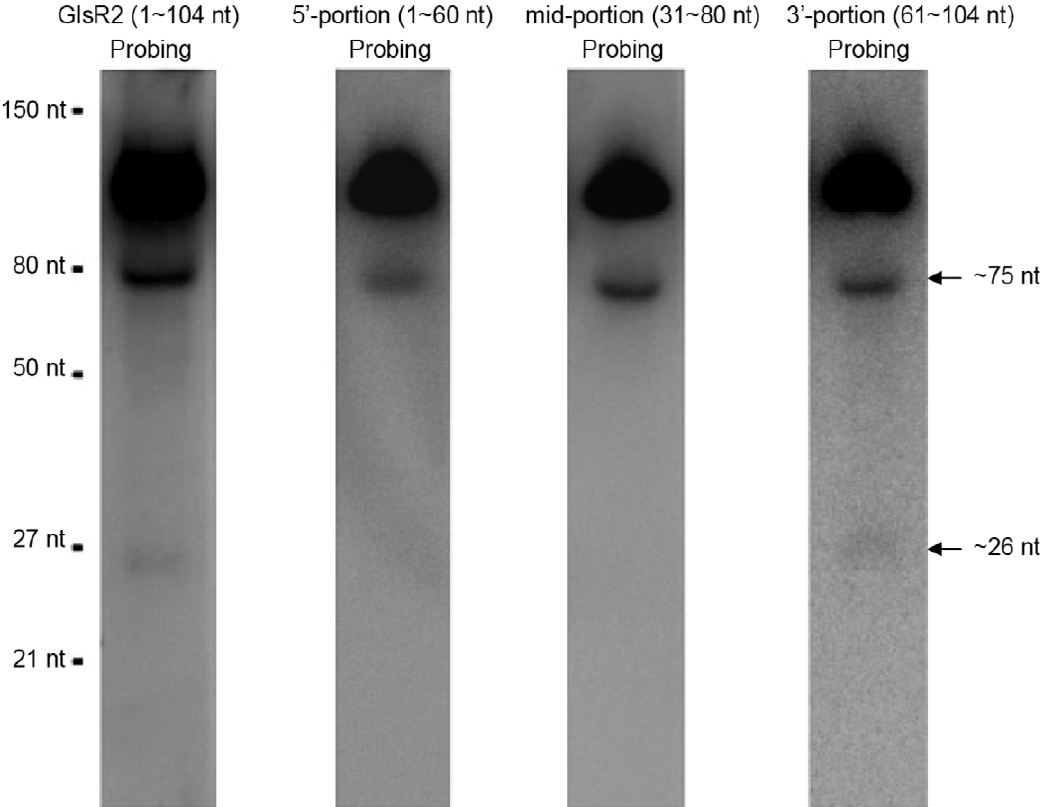
Figure 1. GlsR2 can be processed to a small RNA of 26 nts. Northern blot analysis of GlsR2 using in vitro transcribed antisense RNA of full- length, 5 9 -portion, mid-portion or 3 9 -portion of GlsR2 as probe. Fifteen micrograms of size-fractionated small RNAs ( , 200 nts) were used for each blot. The probe used for the blot is shown on top of each lane.